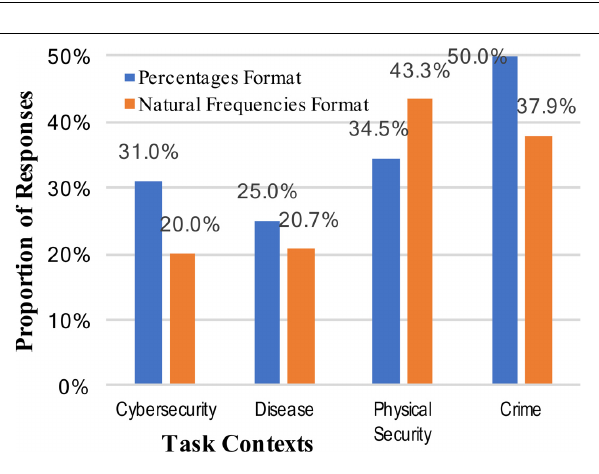
FIGURE 5 | Percentages of participants who incorrectly answered the Bayesian reasoning task with the base-rate / total positive rate (1 or 1%), across the context stories and numerical format